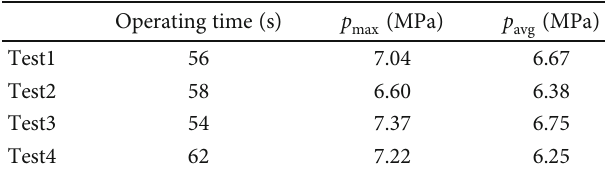
Figure 4: Procedures of image processing method. Table 2: Operating time and pressures of